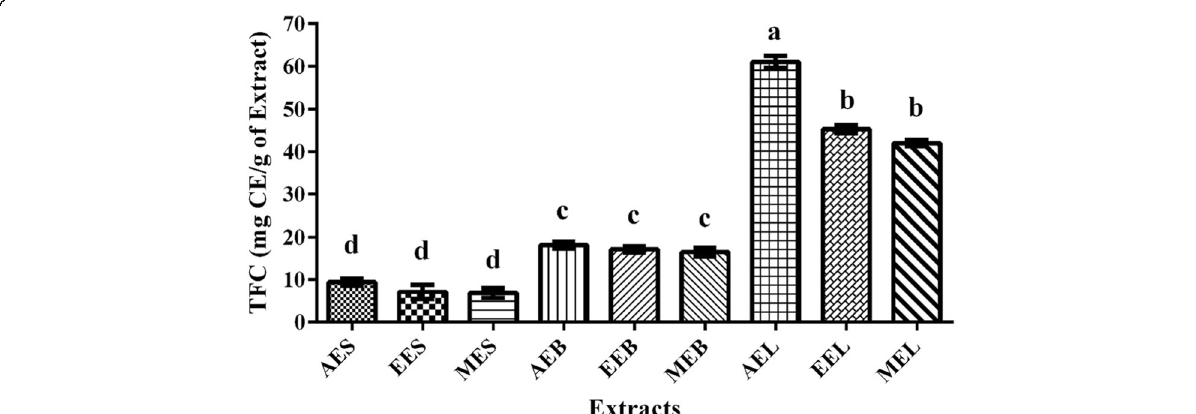
Fig. 2 Total flavonoid content expressed as mg CE (catechin equivalent)/g of extract in different extracts of B. orellana . Bars with different letters are significantly different according to Tukey ’ s HSD tests ( P < 0.05). TFC = total flavonoid content; AES = aqueous extract (seed); EES = ethanolic extract (seed); MES = methanolic extract (seed); AEB = aqueous extract (branch); EEB = ethanolic extract (branch); MEB = methanolic extract (branch); AEL = aqueous extract (leaf); EEL = ethanolic extract (leaf); MEL = methanolic extract (leaf)